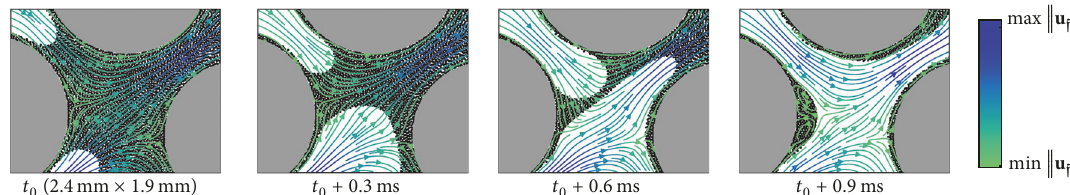
Figure 3: Hydrodynamic wetting film entrainment in subdomain of microstructure A for log 10 ( Ca ,𝑀) = (−2,−1) . Solid phase domain is colored gray whereas WP SPH particles are represented by black markers. NWP SPH particles are omitted for improved visibility. Streamlines are colored according to the magnitude of local fluid